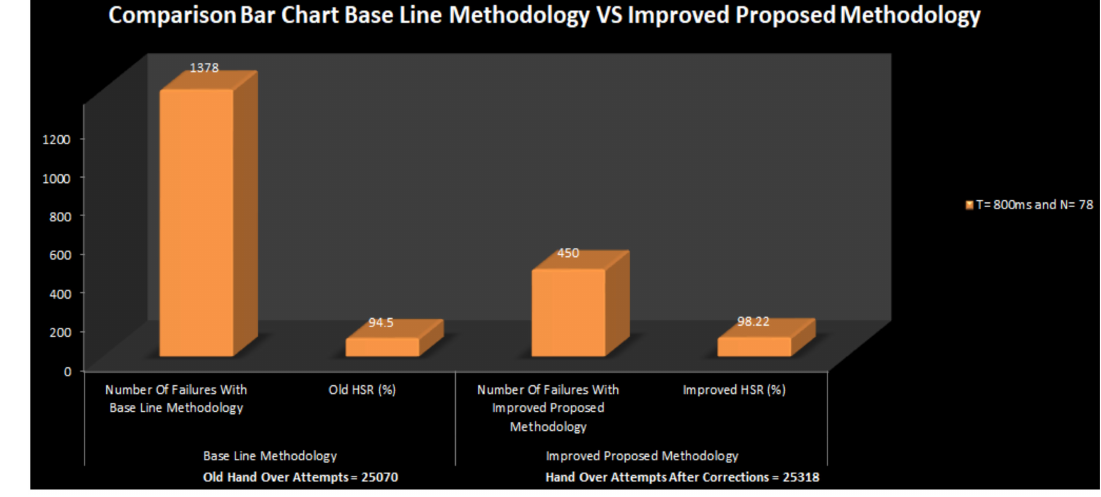
Figure 13. Comparison bar chart.